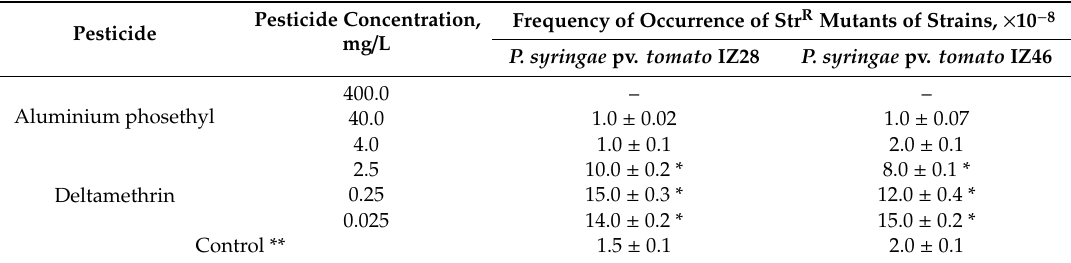
Table 1. Induction of Str R mutations P. syringae pv. tomato for pesticides.